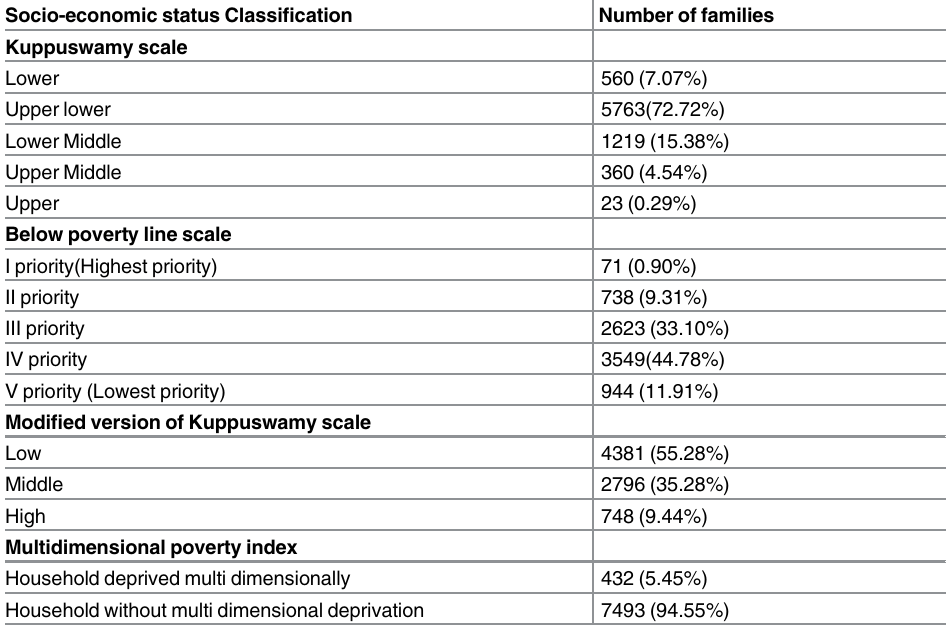
Table 3. Socio-economic status classification of study families by the Kuppuswamy, Below Poverty Line, Modified Kuppuswamy and Multi-Dimensional Poverty Index